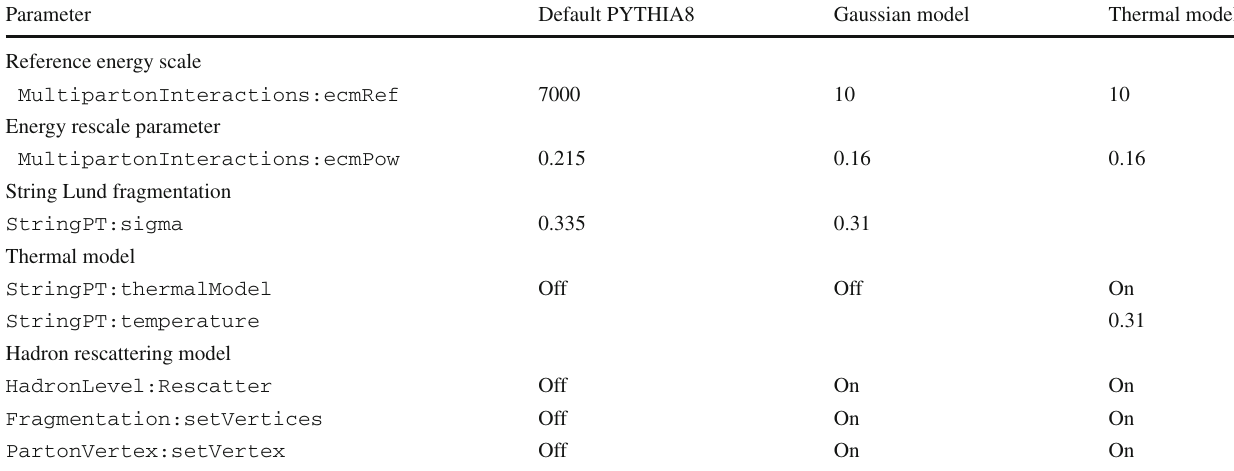
Table 1 PYTHIA 8.303 parameters and their values for pp- and light(er)-ion collisions at SPS energies Parameter Default PYTHIA8 Gaussian model Thermal model Reference energy